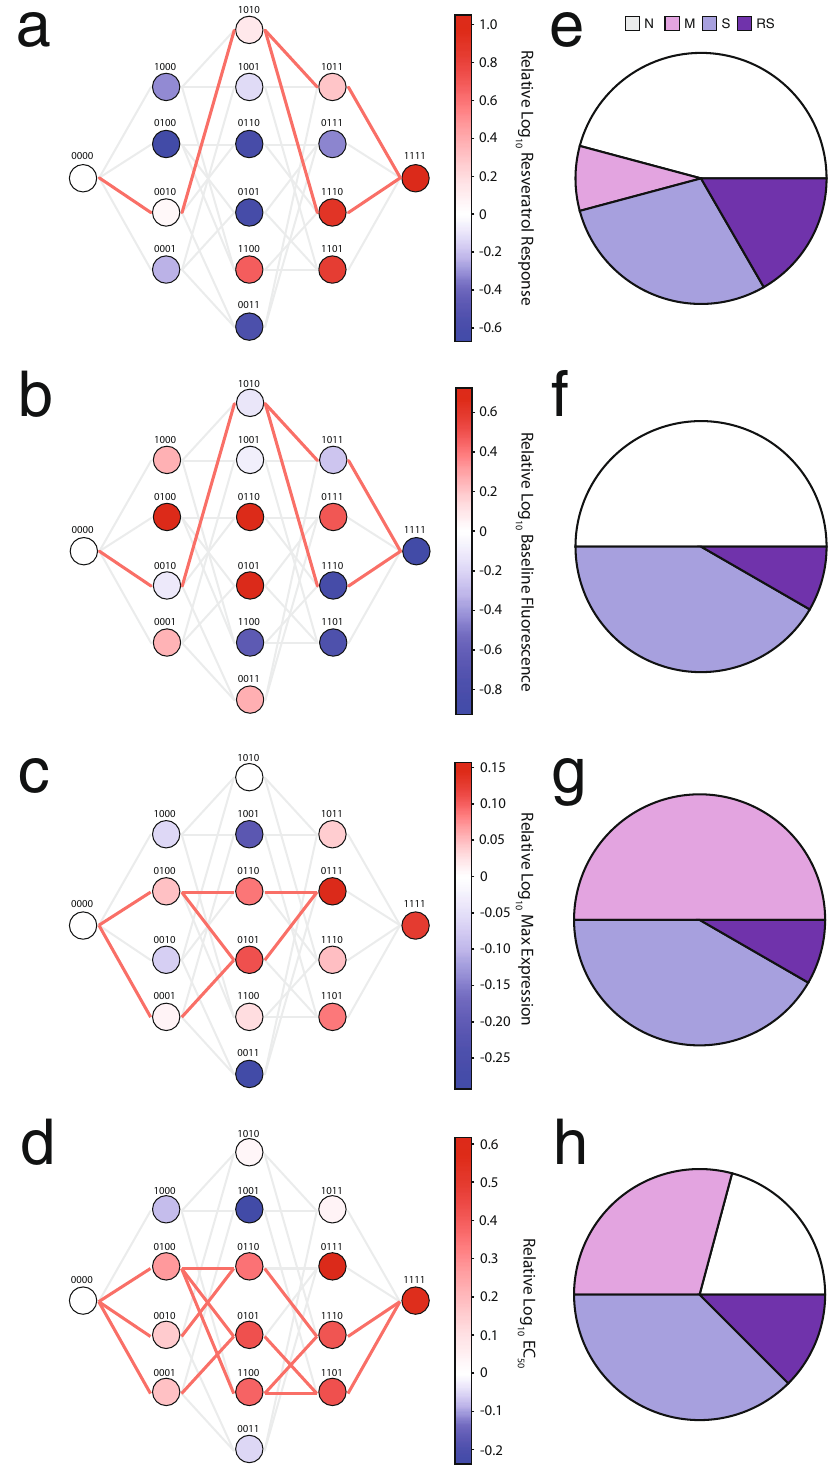
Fig. 2 Fitness landscapes for multiple functional parameters in response to induction with resveratrol. Fitness landscapes of ( a ) fold induction, ( b ) basal gene expression, ( c ) maximum gene expression, and ( d ) EC 50 parameters for all 16 TtgR variants in response to resveratrol with each variant shown as a node in the graph. Each variant is labeled with a binary string corresponding to the presence (1) or absence (0) of a mutation at position 137, 141, 167, or 168 in order. Nodes separated by a single mutation are connected by edges showing viable (bold red) and unviable paths (light gray) through sequence space. Nodes are shaded by log 10 of the fi tness parameter at 250 μ M resveratrol normalized to the fi tness of wild-type TtgR. Number of epistatic subnetworks in the resveratrol ( e ) fold induction, ( f ) basal gene expression, ( g ) maximum gene expression, and ( h ) EC 50 landscape determined by Bahadur expansion. Non-epistatic subnetworks (N) are shown in white, magnitude epistasis (M) in pink, sign epistasis (S) in light purple, and reciprocal sign epistasis (RS) in dark